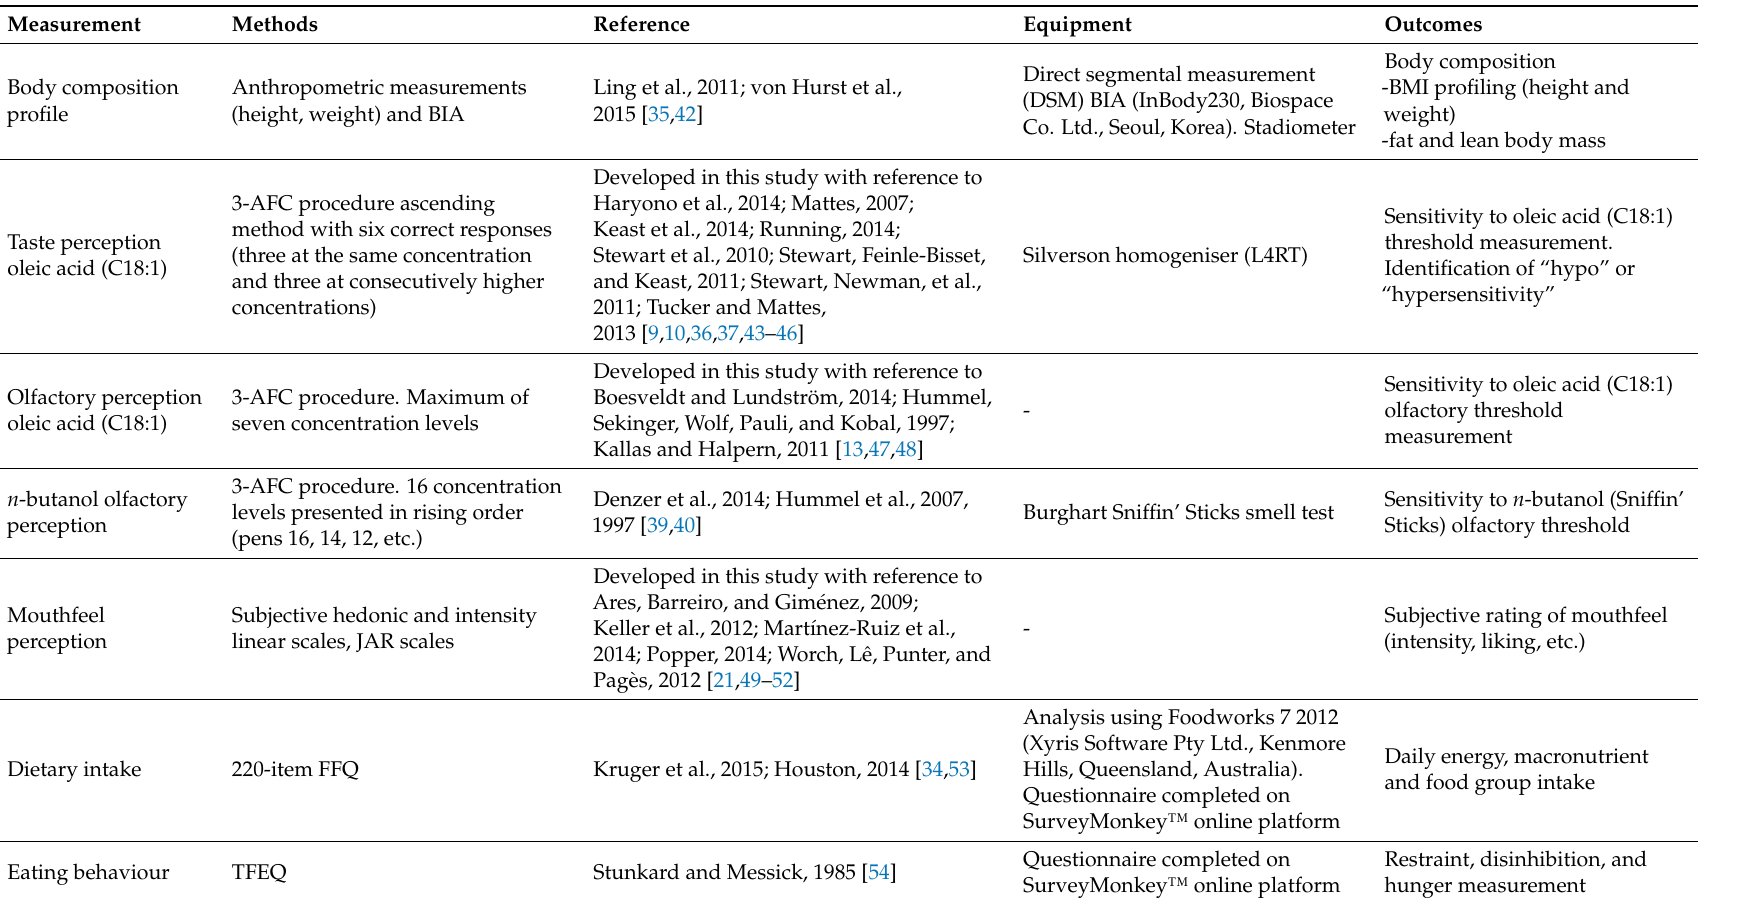
Table 1. Trial measurements and